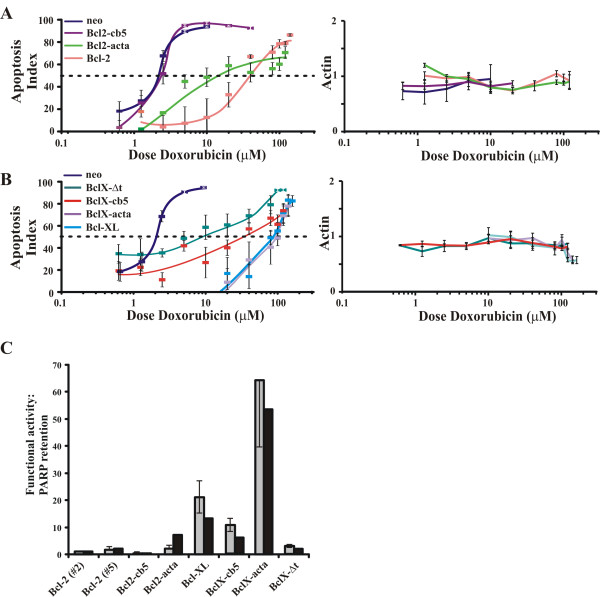
The functional activity of Bcl-XL in preventing doxorubicin induced apoptosis is about ten times greater than that of Bcl-2. Cell lines expressing A) Bcl-2, Bcl2-cb5 or Bcl2-acta and B) Bcl-XL, BclX-cb5, BclX-acta or BclX-Δt were treated with the specified dose of doxorubicin, and plotted against the apoptosis index (measured as in Figure 5). The data representing the dose response curves for vector transfected control cells (neo), Bcl-2 or Bcl-XL expressing cells shown in Figure 5 is duplicated here for comparison. The relative intensity recorded for actin blots prepared from the same samples are shown to the right and indicate that equivalent amounts of protein were analyzed for all samples. Bars indicate standard error of the mean, n ≥ 4. C) The EC50 values in μM doxorubicin for Bcl-2, Bcl-XL and mutants located at the ER (Bcl2-cb5, BclX-cb5), mitochondria (Bcl2-acta, BclX-acta) or cytoplasm (BclX-Δt) as determined from the graphs shown in A) and B). To correct for expression of the individual proteins these values were divided by the concentration of anti-apoptotic protein (expressed as nMol/mg total cell protein normalized to Bcl-2 #2) in each cell line. Grey bars – based on expression levels prior to drug treatment. Black bars – based on expression levels after drug treatment at the EC50.